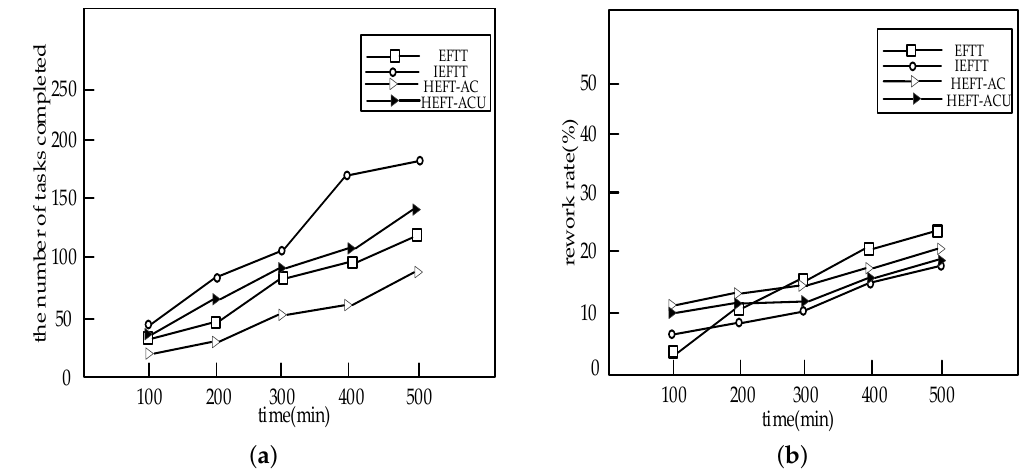
Figure 13. Performance comparisons of the algorithms on dynamic task set: ( a ) Comparison of the number of task completed; ( b ) Comparison of the rework